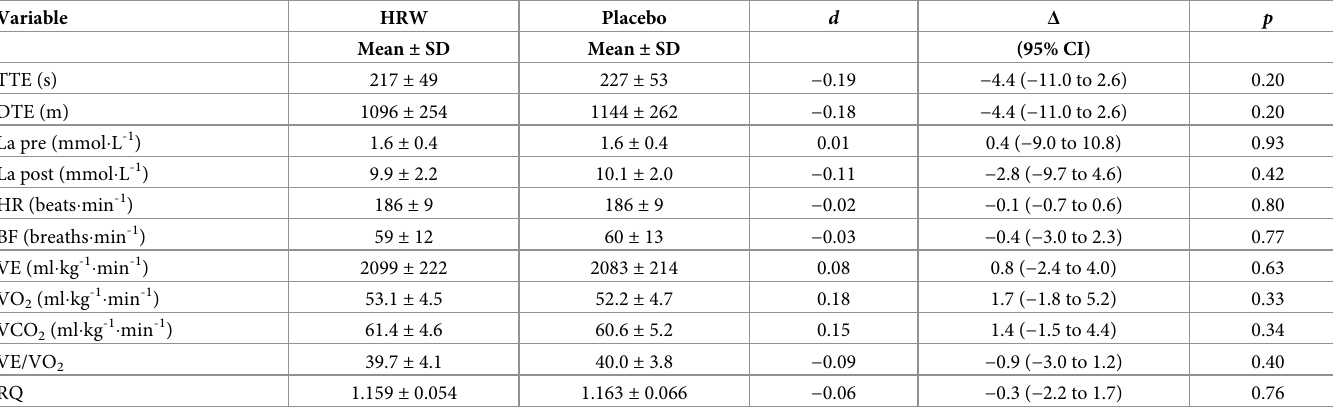
Table 3. Effect of hydrogen rich water compared to placebo on performance and physiological